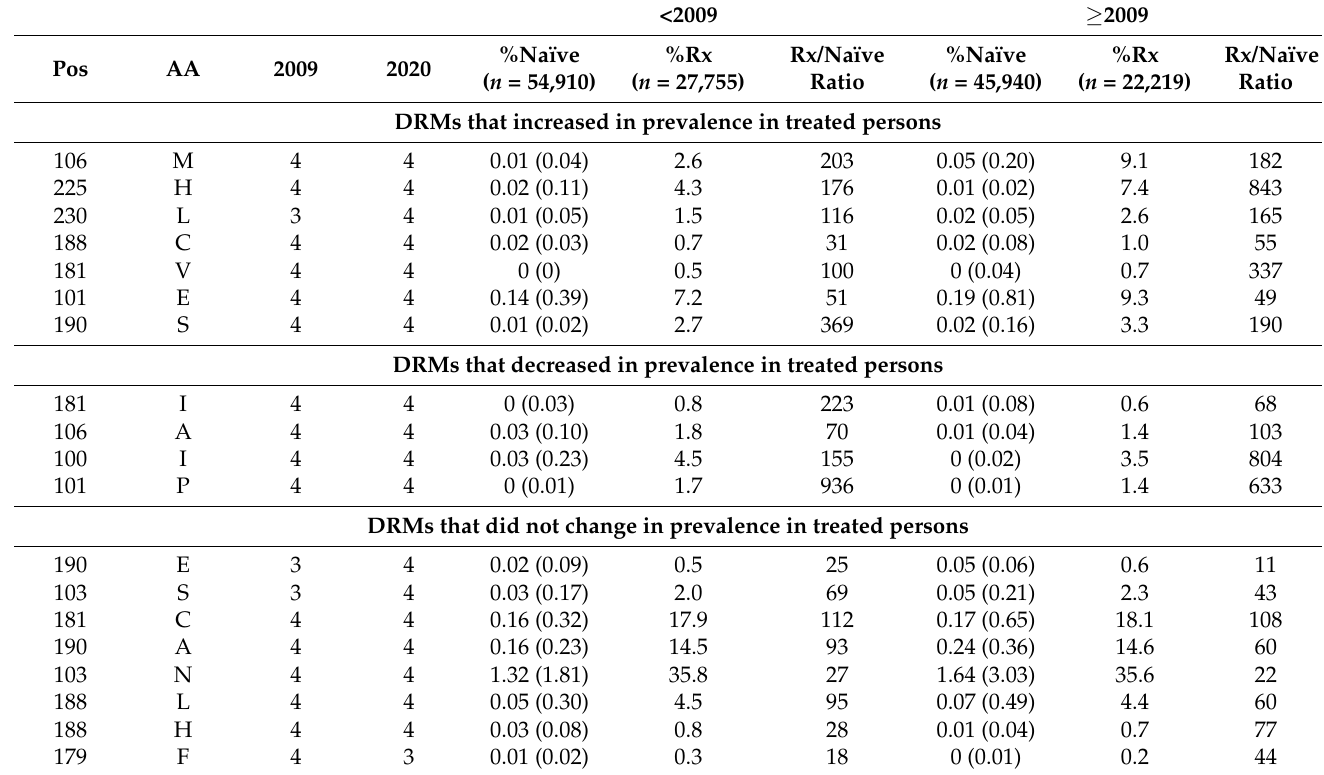
Table 3. Prevalence of Surveillance NNRTI-Resistance Mutations in RTI-Naïve and NNRTI-Experienced Persons before and after